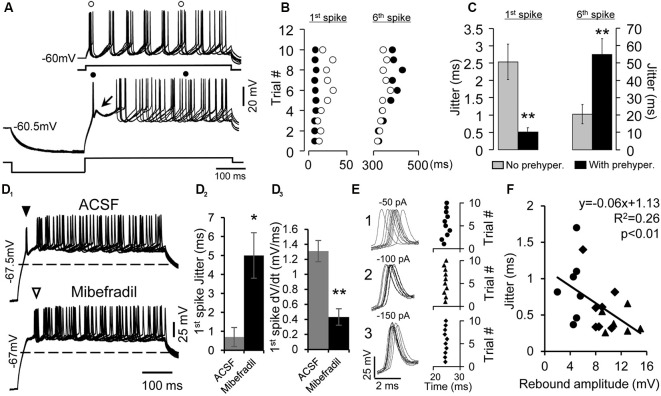
Enhancement of the precision of spike timing by rebound depolarization. (A) Overlapped traces of responses of a rebound neuron induced by five repetitive depolarizing pulses (50 pA, 500 ms) without (top traces) and with pre-hyperpolarizing (−100 pA, 250 ms, bottom traces) pulses. Arrow indicates the rebound. (o) and (•) indicate the first and sixth spikes without or with pre-hyperpolarization. (B) Raster plot of the first and sixth spikes elicited by depolarizing pulses with (•) and without (o) pre-hyperpolarization. Data are from the neuron shown in (A). Each circle represents an action potential. (C) Mean jitter of the first and sixth spikes produced by depolarization with and without pre-hyperpolarization (n = 20). Error bars indicate SEM. Two-tailed Student’s paired t-test, **P < 0.01. (D1) Overlapped traces of responses in a rebound neuron induced by 10 depolarizing pulses (40 pA, 500 ms) with pre-hyperpolarizing pulses (−150 pA, 250 ms) in artificial cerebral spinal fluid (ACSF; top traces) and mibefradil (5 μM, bottom traces). Solid triangle points to first spikes that rode on the rebound. Open triangle indicates first spikes after the rebound was abolished. Dashed lines represent the resting membrane potential level. (D2) Mibefradil significantly increased jitter of the first spikes produced by depolarization with pre-hyperpolarization (n = 6). Error bars indicate SEM. Two-tailed Student’s paired t-test, *P < 0.05. (D3) Mibefradil significantly decreased the rate of membrane depolarization of the first spike (n = 6). Error bars indicate SEM. Two-tailed Student’s paired t-test, *P < 0.01. (E) Overlapped waveforms (left panel) and raster plot (right panel) of the first spikes induced by 10 depolarizing pulses (80 pA, 500 ms) with pre-hyperpolarizing pulses at three levels (−50, −100, and −150 pA). (F) Correlation of the rebound amplitude and spike jitter at pre-hyperpolarization of −50 pA (•), −100 pA (⧫), and −150 pA (▲, n = 7). Pearson’s correlation test, *P < 0.05.